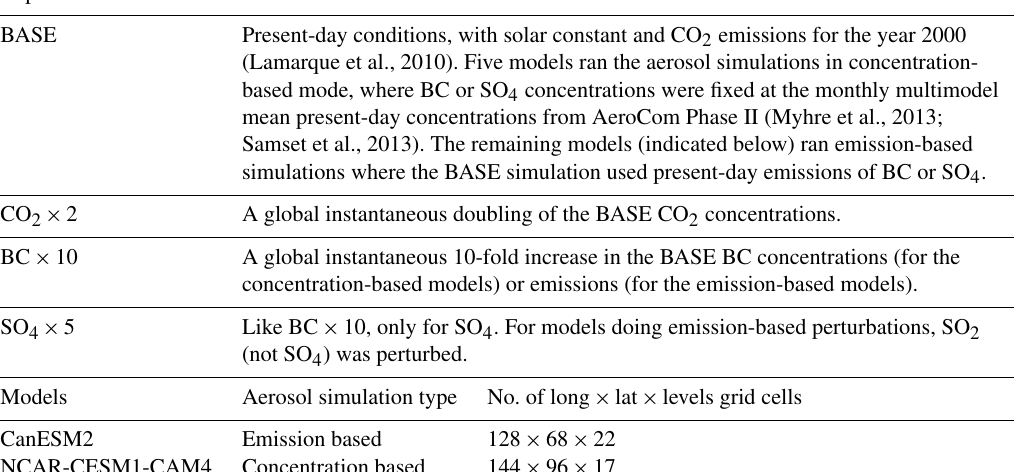
Table 1. Overview of models and experiments. See Myhre et al. (2017a), Samset et al. (2016) and Stjern et al. (2017) for details and a list of models.